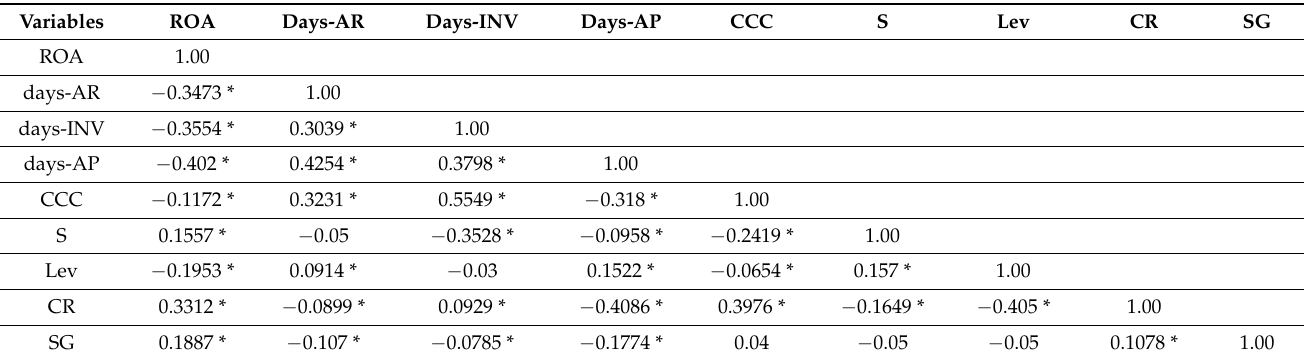
Table 4. The correlation amongst the variables—pre-pandemic period